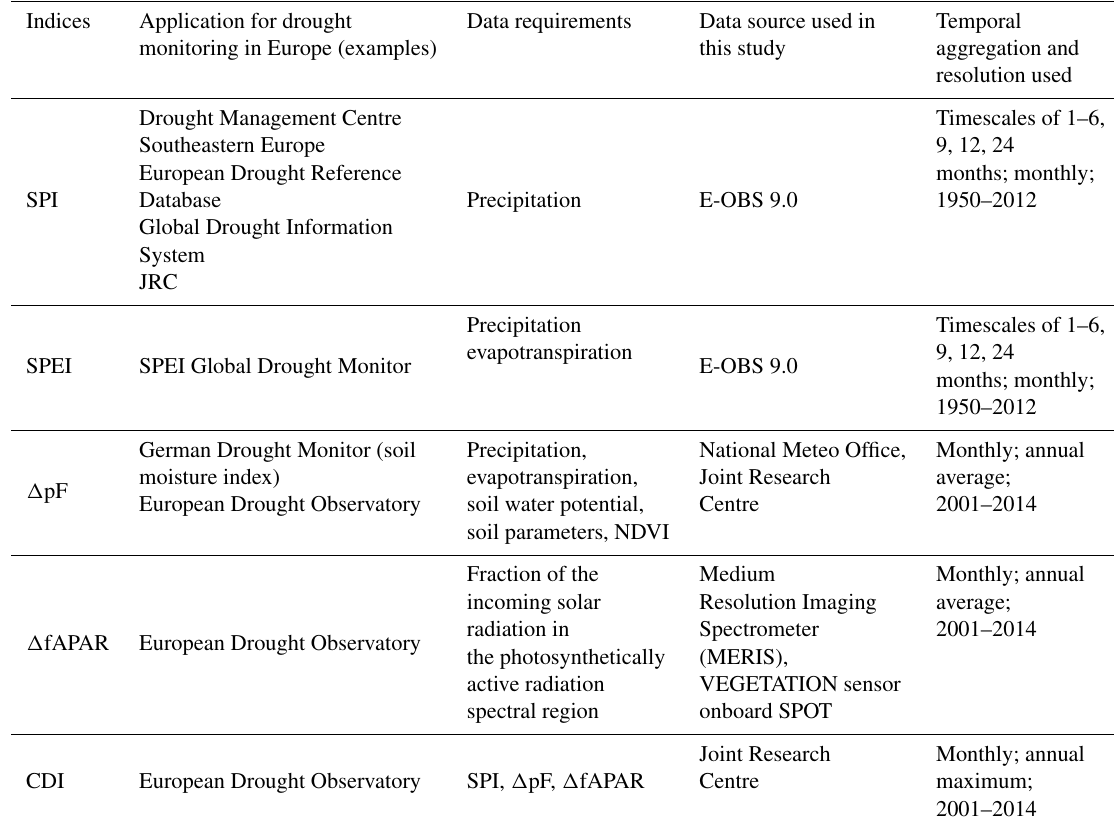
Table 1. Overview of selected drought indices.